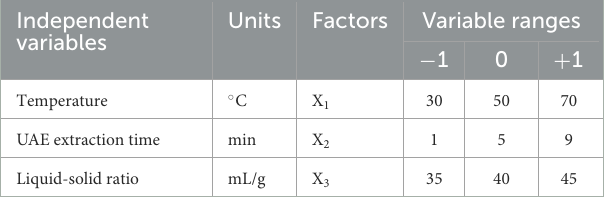
TABLE 1 Experimental ranges and codes of independent factors in the RSM. Independent